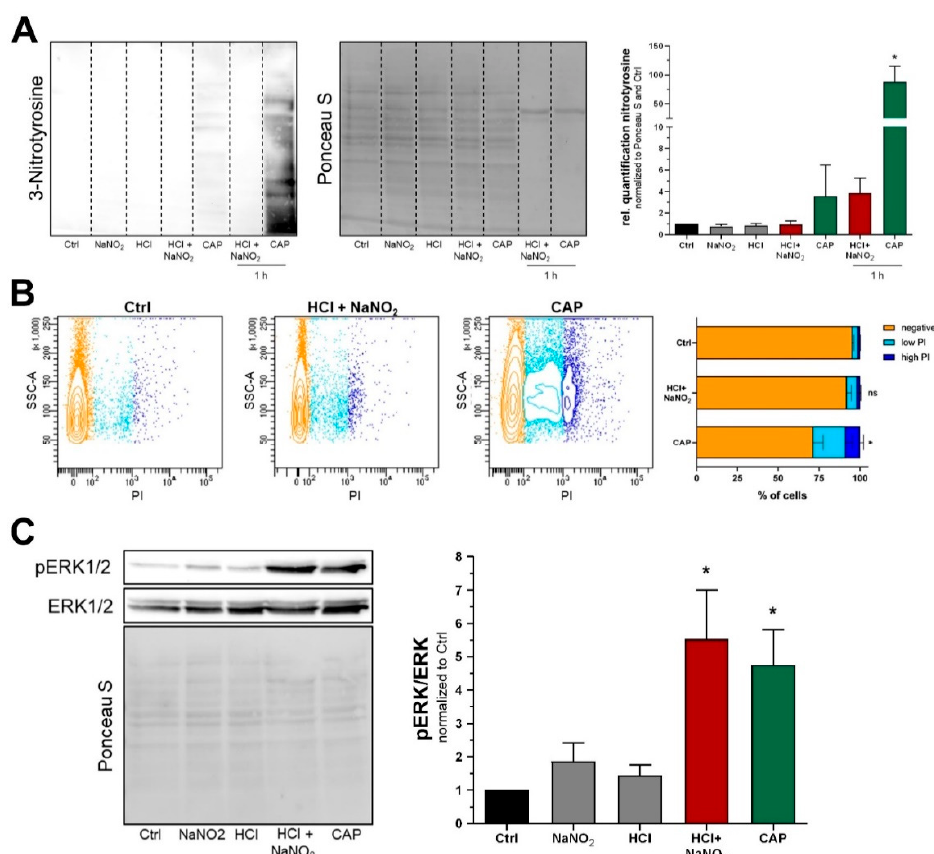
Figure 3. Molecular effects of acidic nitrite solution and CAP. ( A ) Western blot analysis of protein nitration directly after 5 min treatment with acidified nitrite solution or indirect CAP (F (6,14) = 9.437, p = 0.0003). Reference samples of 1 h treatment serve as a positive control. ( B ) Propidium iodide staining in combination with flow cytometry to assess membrane damage after treatment (F (2,6) = 11.62, p = 0.0086). ( C ) Western blot analysis of pERK1/2 and ERK1/2 after treatment with acidic nitrite solution or indirect CAP (F (4,10) = 7.404, p = 0.0049). Control treatment (Ctrl) refers to ECS without nitrite at pH 7.4. Bars are shown as mean ± SEM (ANOVA followed by Tukey’s HSD post-hoc test vs. Ctrl, n = 3, *: p <